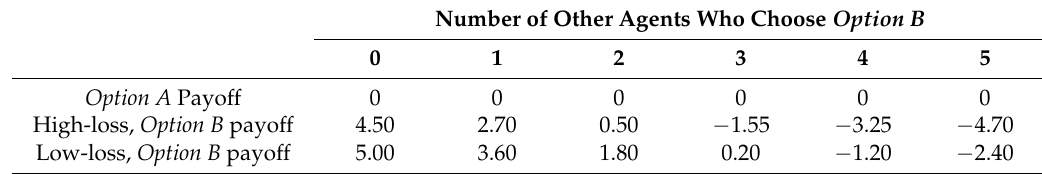
Table 2. Payoffs by type and option choice for endowment = 7.